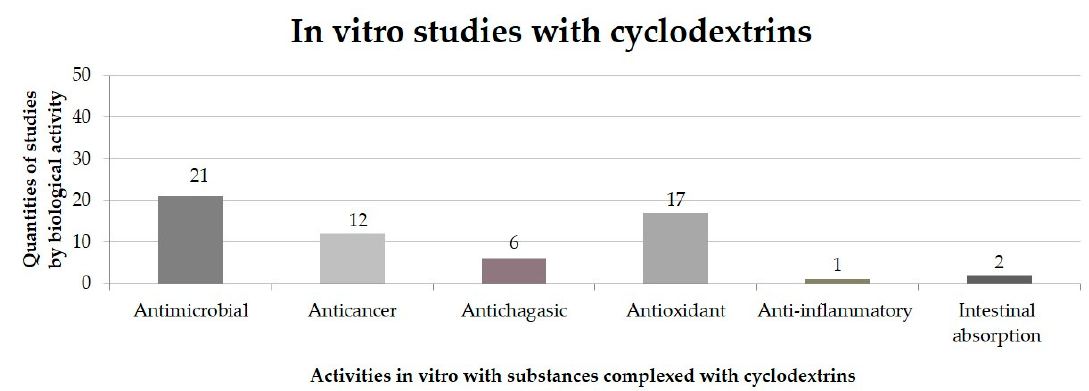
Figure 5. Quantities of in vitro studies performed with substances in inclusion complexes with cyclodextrins, according to works published in the literature from 2001 to 2019.